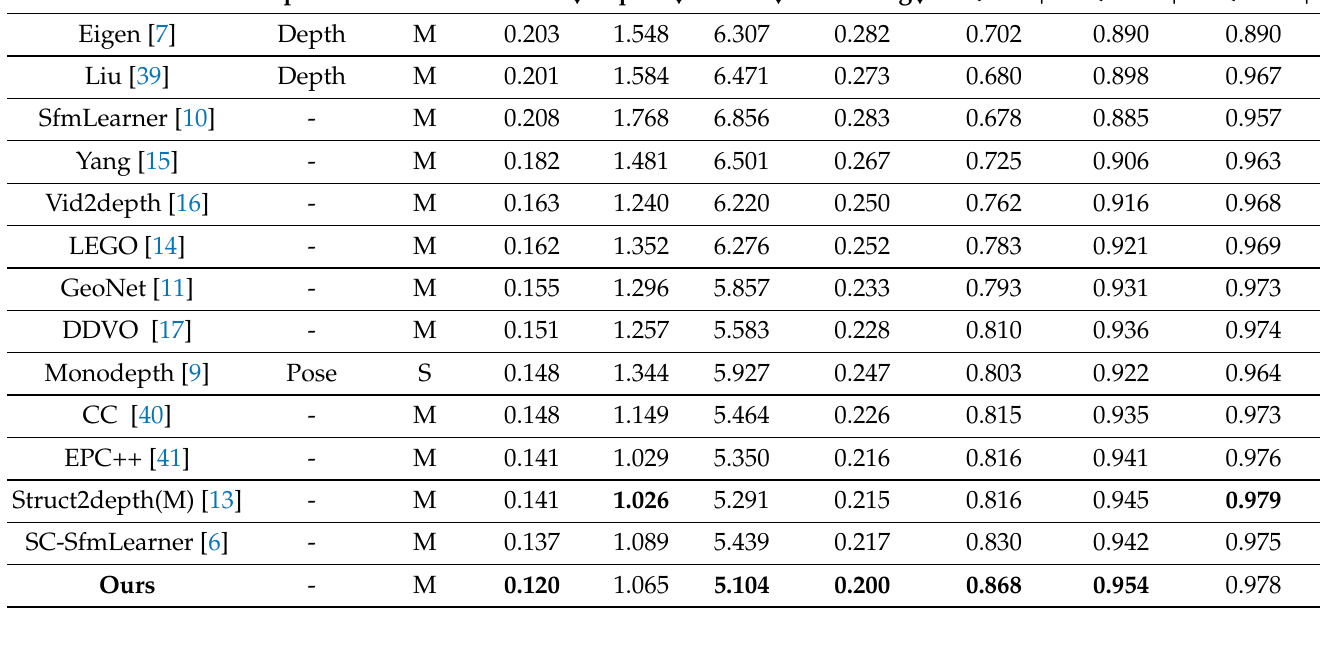
Table 2. Depth estimation quantitative results on Eigen [7] split of KITTI raw dataset [37], capped at 80 m. These methods are all trained on KITTI raw dataset. The camera column denotes whether stereo camera is used, M means monocular, S indicates stereo. The supervised column denotes whether using additional supervised information. In the first row, the upward arrow ↑ indicates higher is better, the downward arrow ↓ means lower is better. Best results in each category are in bold.